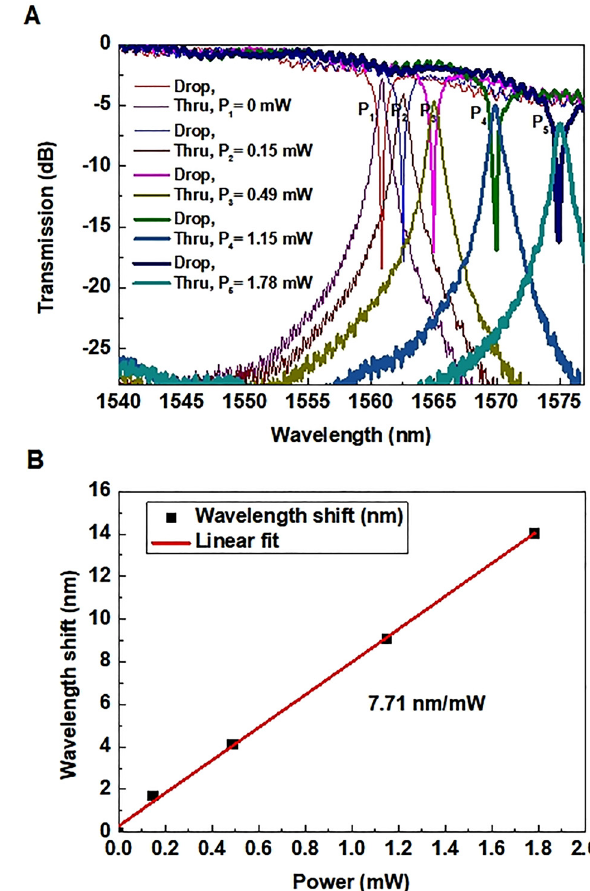
Figure 7: Transmission spectra of the device and the fitting